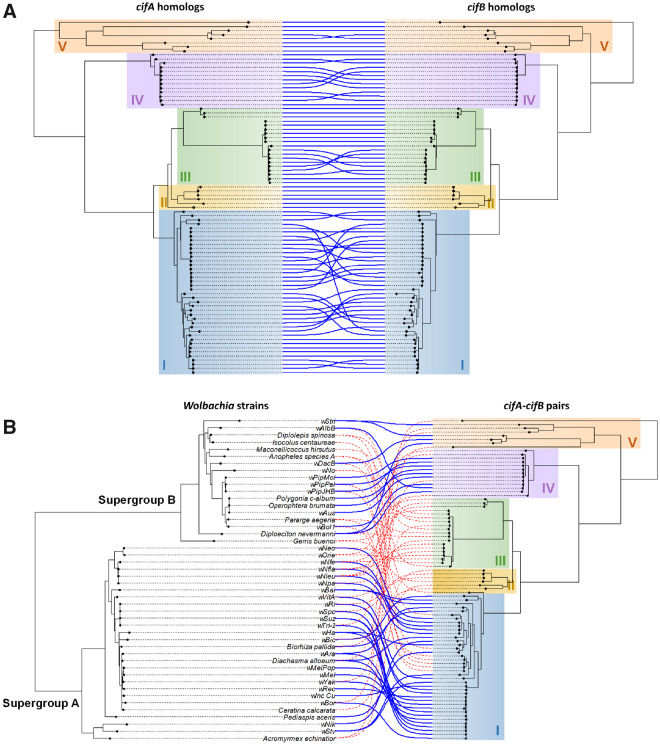
Phylogenetic congruence between cif genes and Wolbachia strains. (A) Cophylogeny of syntenic cifA and cifB genes. (B) Cophylogeny of Wolbachia genomes and the cifA–cifB genes. Links between phylogenies indicate (A) syntenic genes and (B) Wolbachia strain–cif gene associations, respectively. Blue links have a significant contribution to the global cophylogenetic signal in the Parafit test and red links do not.